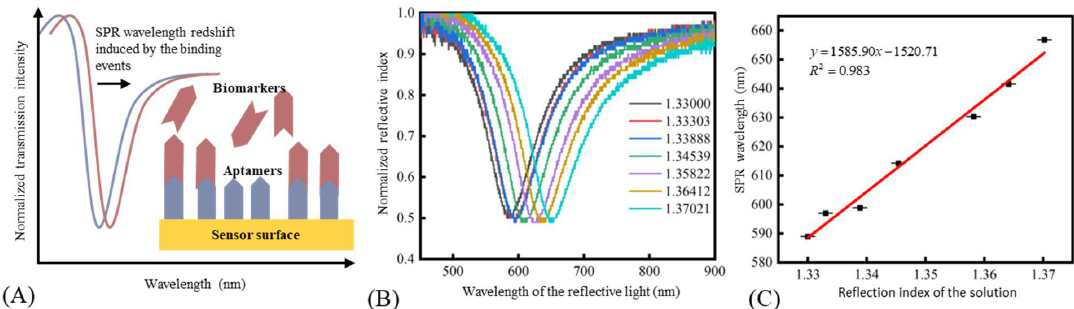
Figure 3. ( A ) The measurement principle of SPR biosensors. ( B ) The normalized spectrum of the sensor under solutions with different RIs. ( C ) The relationship between the SPR wavelength and the refractive index of the solutions.